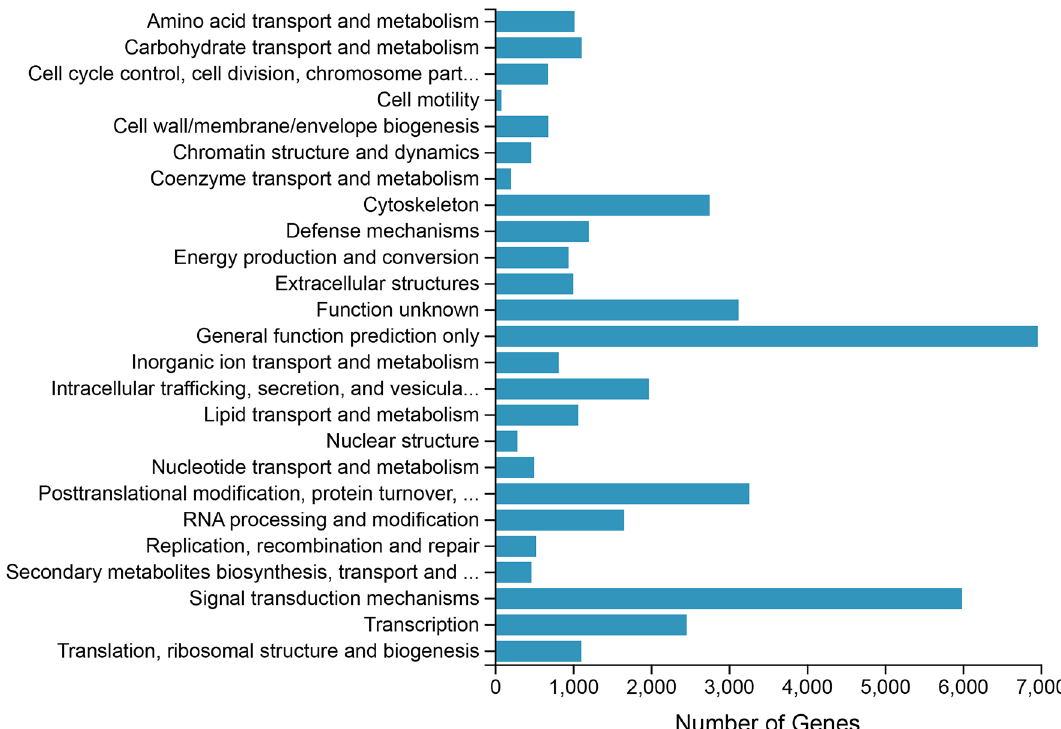
Figure 2. Clusters of KOG functional classifications.